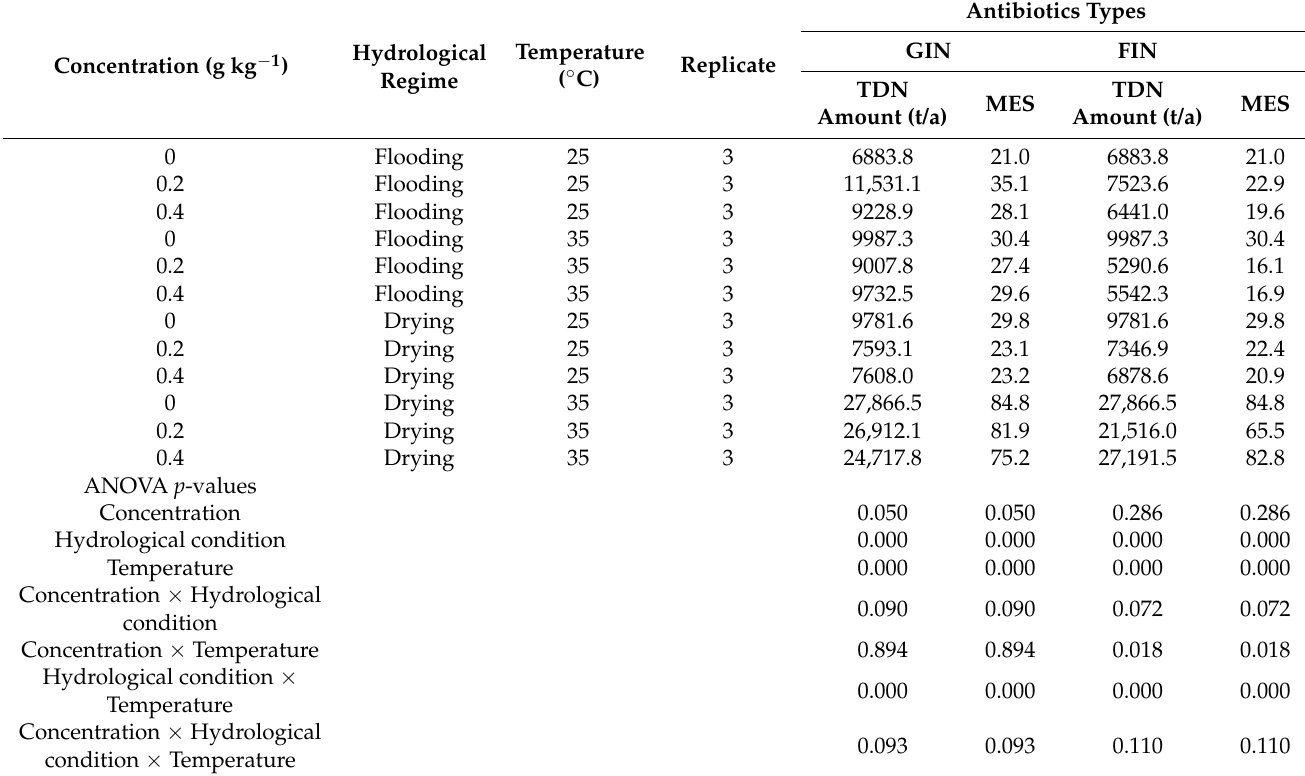
Table 2. TDN inputs amount and multiple exceeding standard (MES). ANOVA p -values of concentration, hydrological regime and temperature on TDN inputs amount and MES were presented by the linear mixed